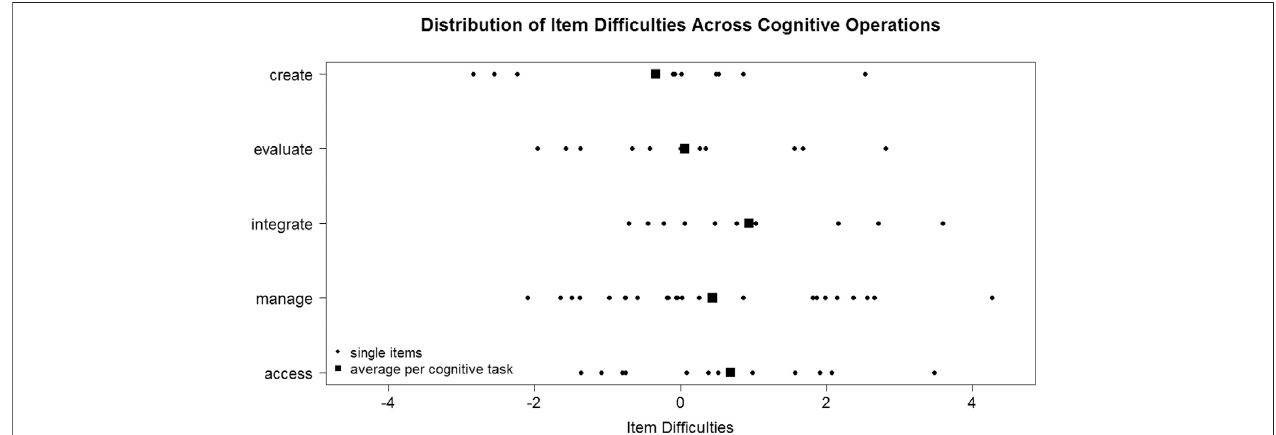
FIGURE 1 | Empricial item dif fi culties for items assessing the fi ve cognitive